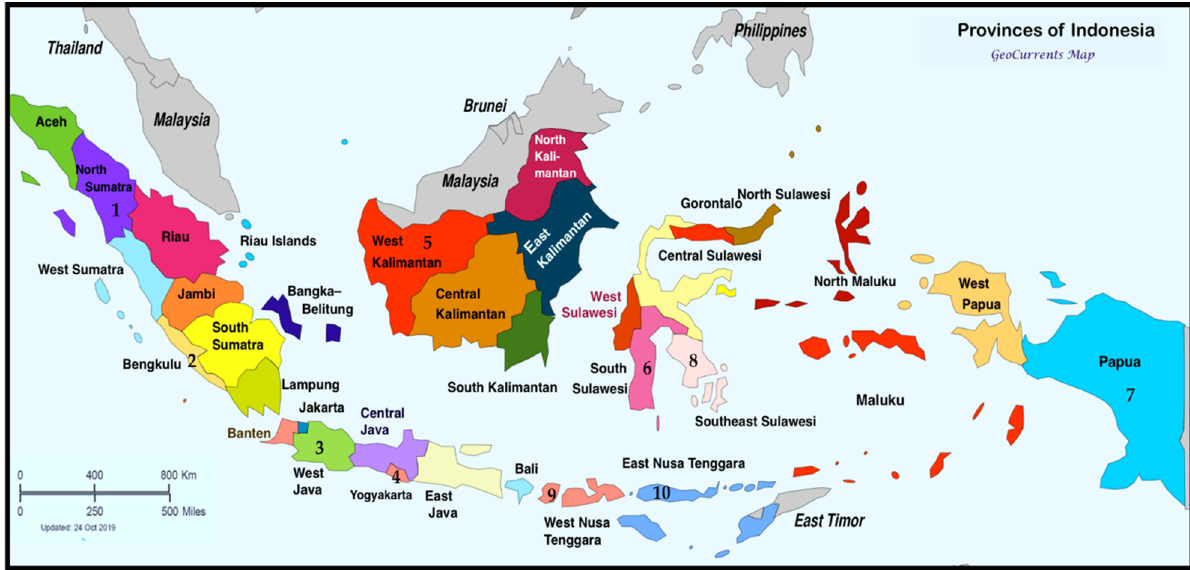
Figure 1. Map locating the ten provinces of Indonesia designated as study areas. The numbers indicate the provinces, as shown in Table 1. Table 1. Location, number of cooperative farmers and water sources in farmer participatory demonstration plots on rainfed lowland rice in ten provinces in Indonesia, 2019.